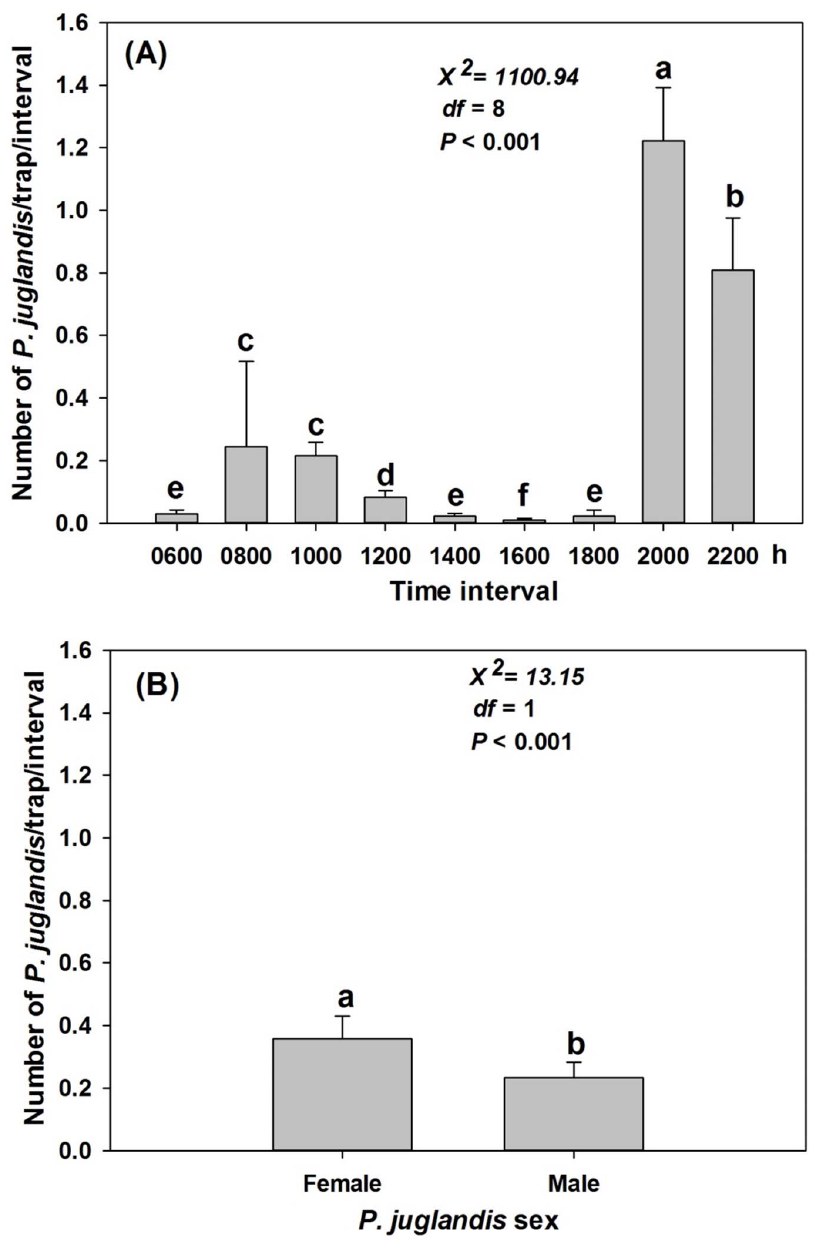
Figure 8. Effects of time interval of the day and Pityophthorusjuglandis sex on P.juglandis catches (mean + SE). (A) Effect of time interval; (B) Effect of P. juglandis sex. Time intervals: 0600 h: 2200 h the previous day–0600 h the current day; 0800 h: 0600–0800 h; 1000 h: 0800–1000 h; 1200 h: 1000–1200 h; 1400 h: 1200–1400 h; 1600 h: 1400–1600 h; 1800: 1600–1800 h; 2000 h: 1800–2000 h; and 2200 h: 2000–2200 h. Different lower-case letters above bars denote significant difference between time intervals (A) or between P. juglandis sexes (B) at a =0.05. N time interval =268 except the time interval 0800 when N =266. N sex =1205 for both sexes. Means plotted in (B) represent catches per 2 h interval. doi:10.1371/journal.pone.0105945.g008 (Fig. 5). Low light intensity or darkness was associated with the cessation of P. juglandis flight activity; as the seasonal period of daylight shortened, P. juglandis flights between 2000 and 2200 h declined and ceased on 3 September, 2012 (Fig. 2C, green arrow).